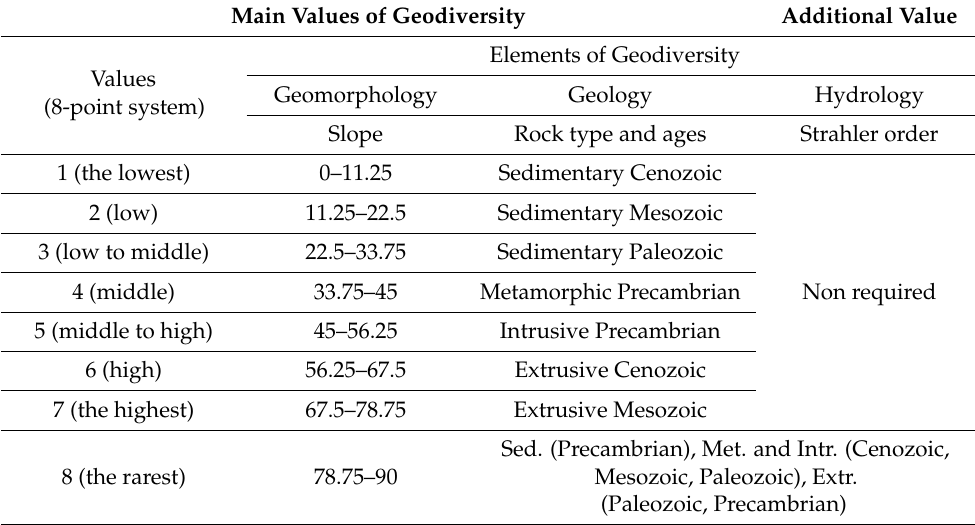
Table 1. The 8-point value systems for geodiversity assessment with hydrological element. Main Values of